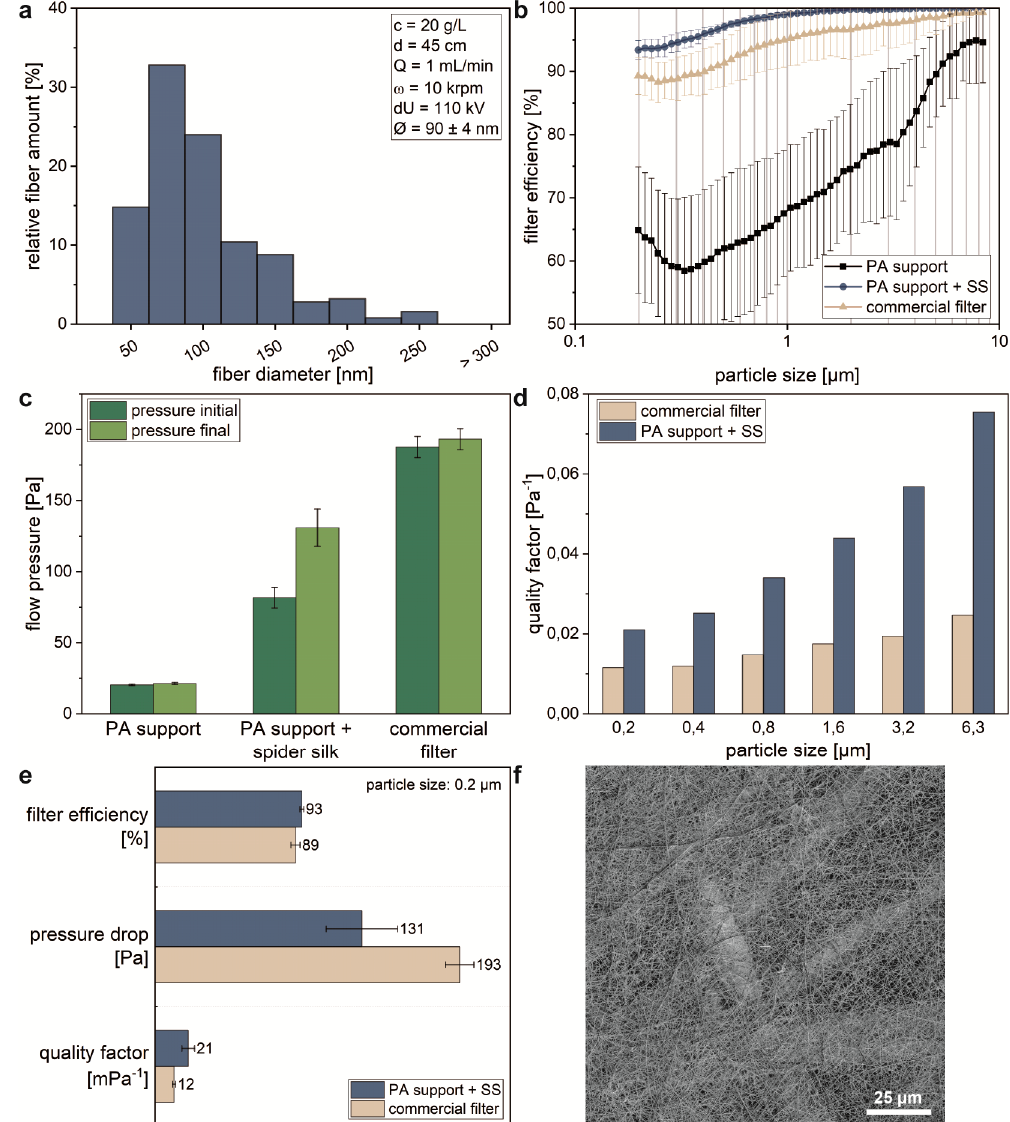
Figure 4. Characterization of spider silk nonwoven meshes as filter material. ( a ) The fiber diameter distribution shows that the majority of the silk fibers in the filter are nanofibers (i.e., <100 nm in diameter); 250 independent samples ( n = 250) were tested. ( b ) Filter efficiency and ( c ) air drag comparisons of polyamide (PA) support, spider silk-covered PA support, and a commercial three-layer dust filter. For each experimental group, 10 independent samples ( n = 10) were tested. ( d ) Quality factor of spider silk containing filter setup in comparison to a commercial filter. ( e ) Filter characteristics of uncovered polyamide support, spider silk (SS)-covered PA support, and the commercial filter determined using 0.2 µm particles. ( f ) SEM image of spider silk-covered PA support used as particle filter before filtration.